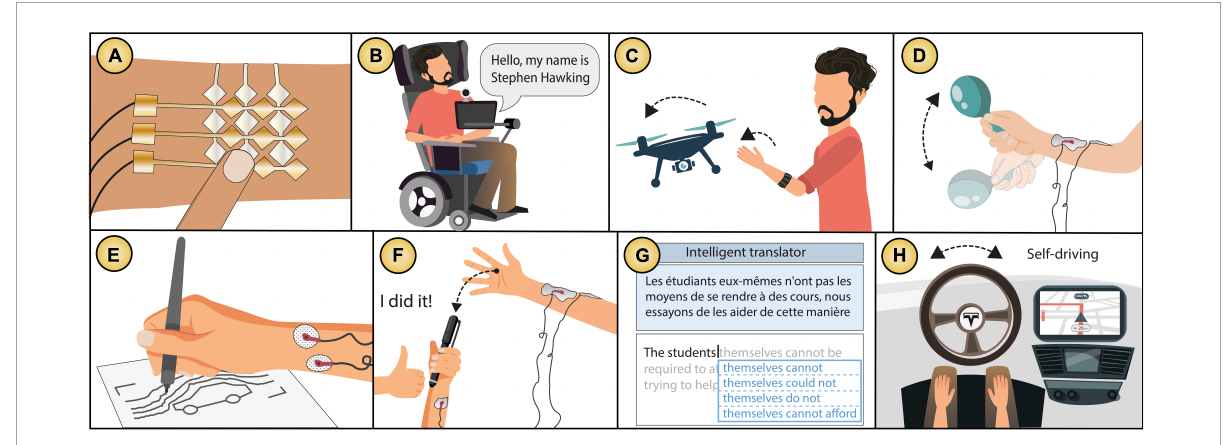
FIGURE9 Examples of action augmentation technology: (A) Skin electronics that make the user’s skin an input modality (Kao et al., 2016), (B) a text entry system controlled by facial expressions (Hemsley, 2018), (C) a drone controlled through EMG sensors (Hockett, 2017), (D–F) electric muscle stimulation that assists in (D) rhythmic tasks (Ebisu et al., 2017), (E) plotting tasks (Lopes et al., 2016), (F) reaction time acceleration (Kasahara et al., 2019), (G) an autocompletion predictor to translate text (Heer, 2019), and (H) a Tesla vehicle in autopilot mode (Tesla, 2022). Images based on the original publications.